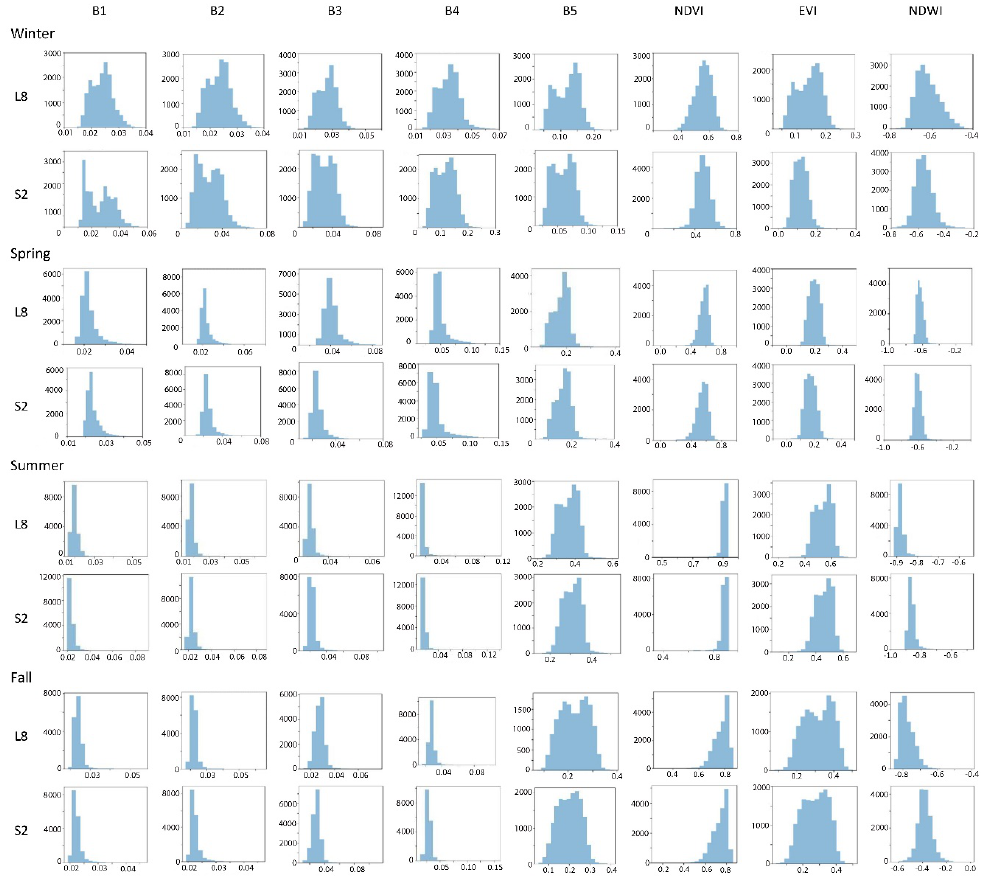
Figure 6. Histogram frequencies of investigated variables (B1, B2, B3, B4, B5, NDVI, EVI and NDWI) corresponding to the Landsat-8 and Sentinel-2A for each season.